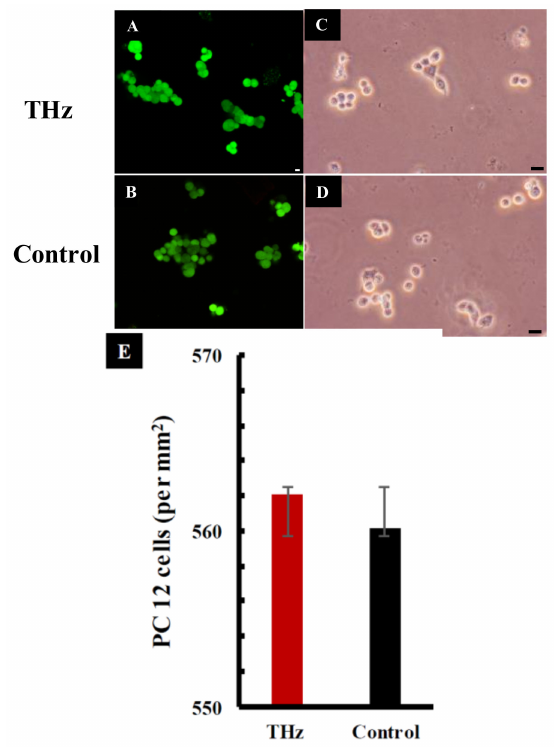
Figure 4. Physiological analysis of PC 12 cells after THz exposure of 10 min. ( A ) Confocal laser scanning images showing viable (green) PC 12 cells after being exposed to synchrotron source THz radiation for 10 min. ( B ) The untreated control cells. Scale bar is 5 µ m. ( C ) Optical micrographs of PC 12 cells following exposure to THz radiation and ( D ) the untreated control. Scale bar is 10 µ m. ( E ) Quantification of viable PC 12 cells following exposure to THz radiation. No significant changes in cell viability were detected between the THz treated and the control group ( p = 0.977). Data are presented as mean ± SD and are representative of the three independent